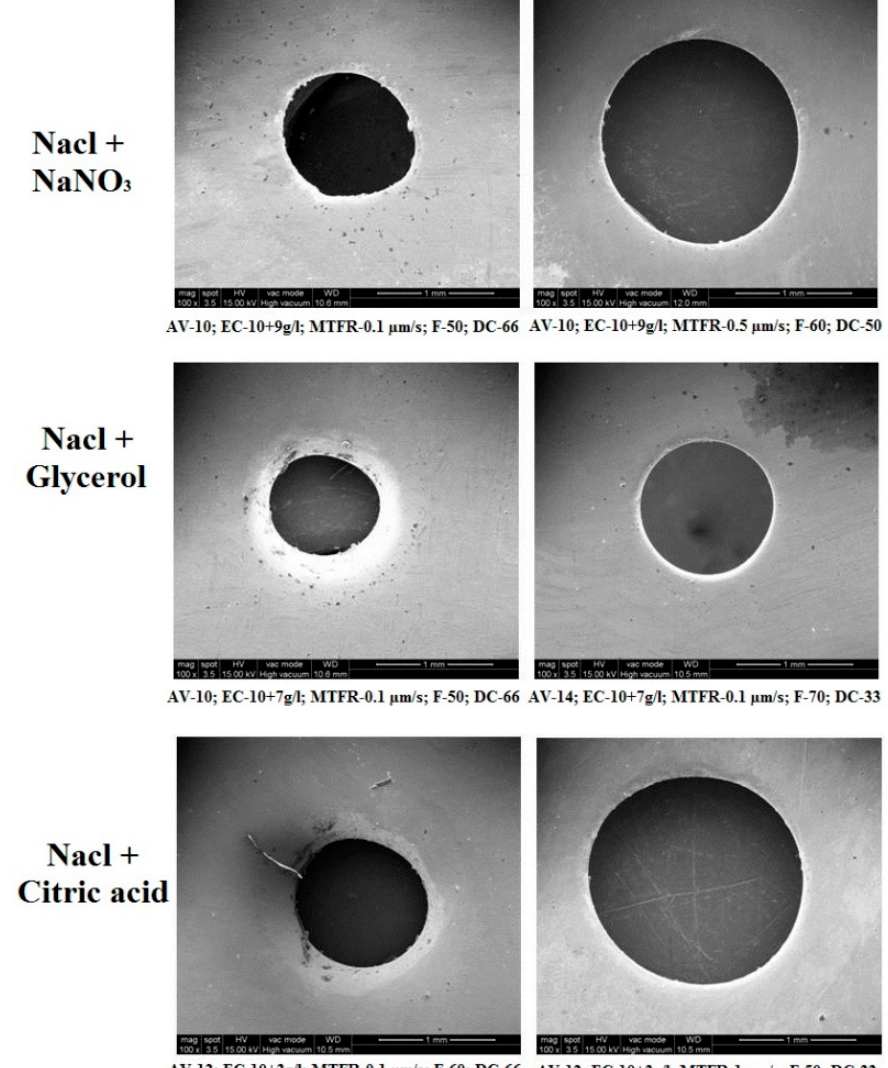
Figure 8. Effects of different electrolyte combinations on circularity using the ECMM process.